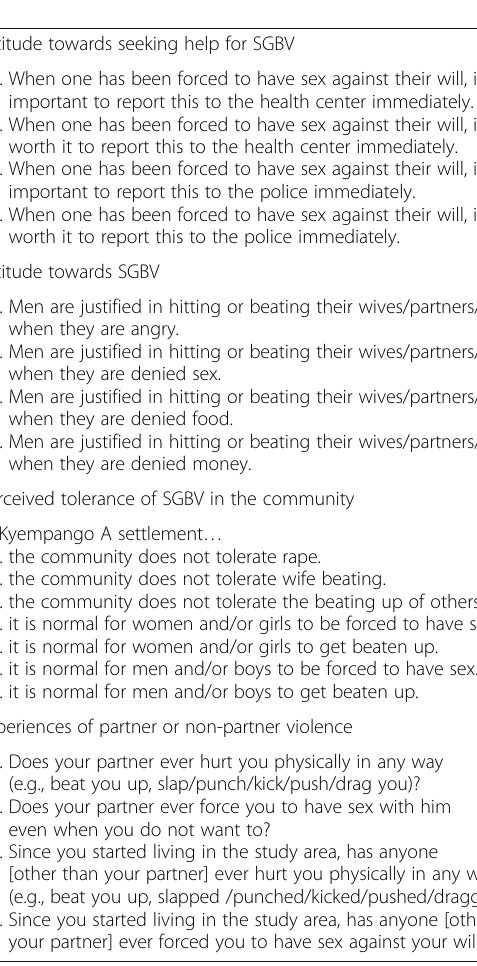
Table 1 Measurement of Attitude towards seeking help for SGBV, Attitude towards SGBV, Perceived tolerance of SGBV in the community and Exposure to